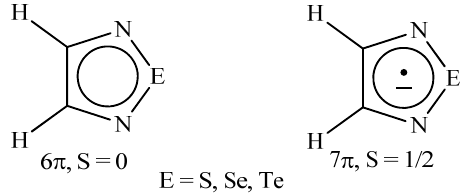
Figure 1. Archetypal 1,2,5-chalcogenadiazoles and their radical